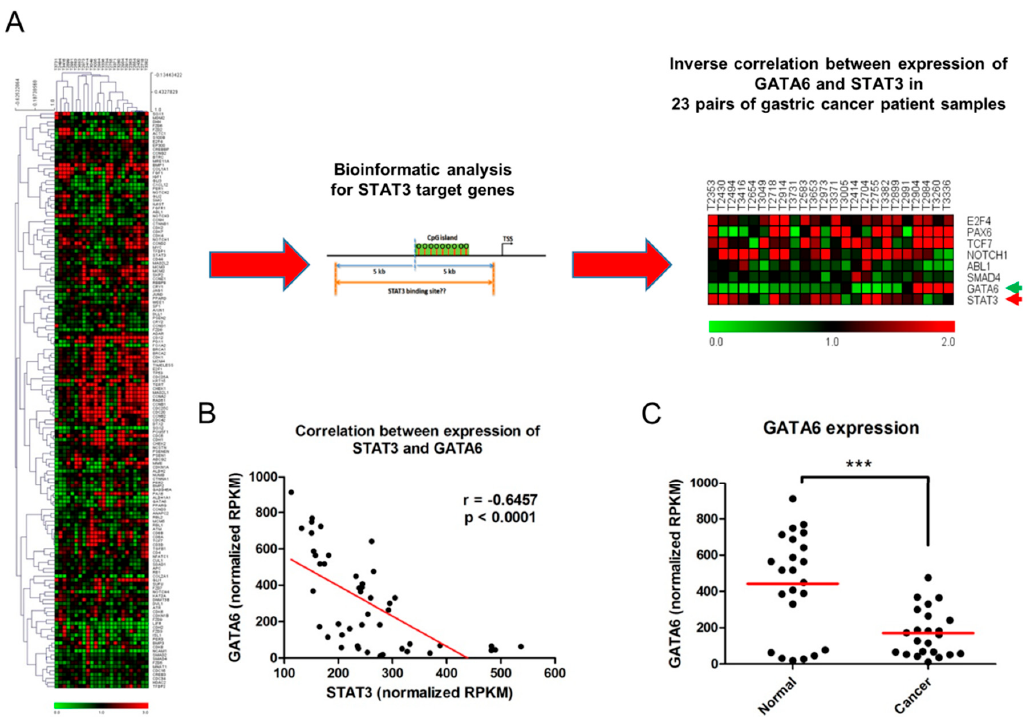
Figure 1. Inverse correlation between the expression of signal transducer and activator of transcription 3 ( STAT3 ) and GATA6 in gastric cancer: ( A ) Heatmap showing the expression profile for 23 pairs of gastric cancer patients investigated in the RNA-Seq experiment (Please refer to Figure S1 for a higher resolution version of the heatmap). Bioinformatic analysis was used to identify potential STAT3 targets by filtering genes with at least one STAT3 binding site within 5 kb of the promoter CpG island. Integration of RNA-Seq and bioinformatic analyses identified several genes, including GATA6 , which were correlated with the expression of STAT3 ; ( B ) Scatter plot illustrates the inverse correlation between the expression of STAT3 and GATA6 among 23 pairs of gastric cancer patients; ( C ) Dot plot shows a significantly higher expression of GATA6 in adjacent normal tissues than that of cancer tissues (*** p < 0.001). Red bar indicates median. TSS: transcription start site; RPKM: reads per kilobase per million.